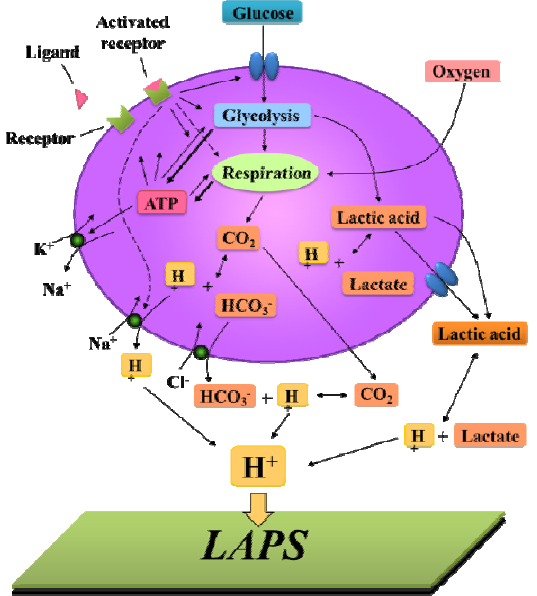
Figure 18. Schematic diagram of extracellular acidi fi cation induced by cellular metabolism and physiological processes. With receptor stimulation, the cellular physiological activities will be affected. The corresponding ATP consumption is compensated by the increased uptake and metabolism of glucose, which results in an increased secretion of acidic products. The extracellular acidification can be detected by LAPS. (Reprinted from